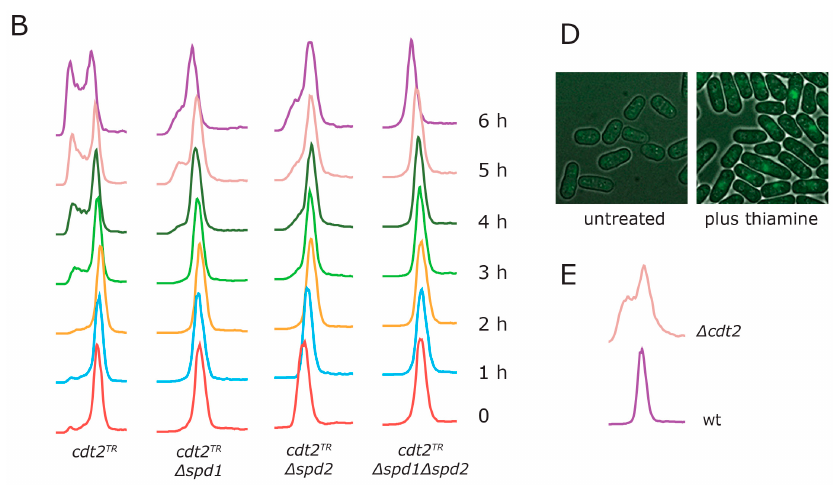
Figure 1. Characterization of the cdt2 TR allele. ( A ) cdt2 TR cells were grown in minimal sporulation liquid (MSL) medium at 30 ◦ C. The culture was divided in two, thiamine was added to the indicated culture, and pictures were taken with Nomarski optics after 12 h; ( B ) cdt2 TR cells of the indicated genotype were grown at 30 ◦ C in MSL medium. At t = 0, thiamine was added to the four cultures. Samples were passed through flow cytometry at hourly intervals, as indicated. The apparent slight drift to the left at early time points in the ∆ spd2 strain was due to a DNA staining artefact; ( C ) Serial dilutions of strains with the indicated genotypes were spotted on plates either with or without thiamine, and incubated at the indicated temperature for three days; ( D ) cdt2 TR cells expressing VN173-pcn1 and spd1-VC155 [6] were propagated in minimal sporulation liquid (MSL). The culture was divided in two, thiamine was added to the indicated culture, and pictures of yellow fluorescent protein (YFP) fluorescence were taken after four hours; ( E ) DNA content profiles of growing wild type and ∆ cdt2 cells.